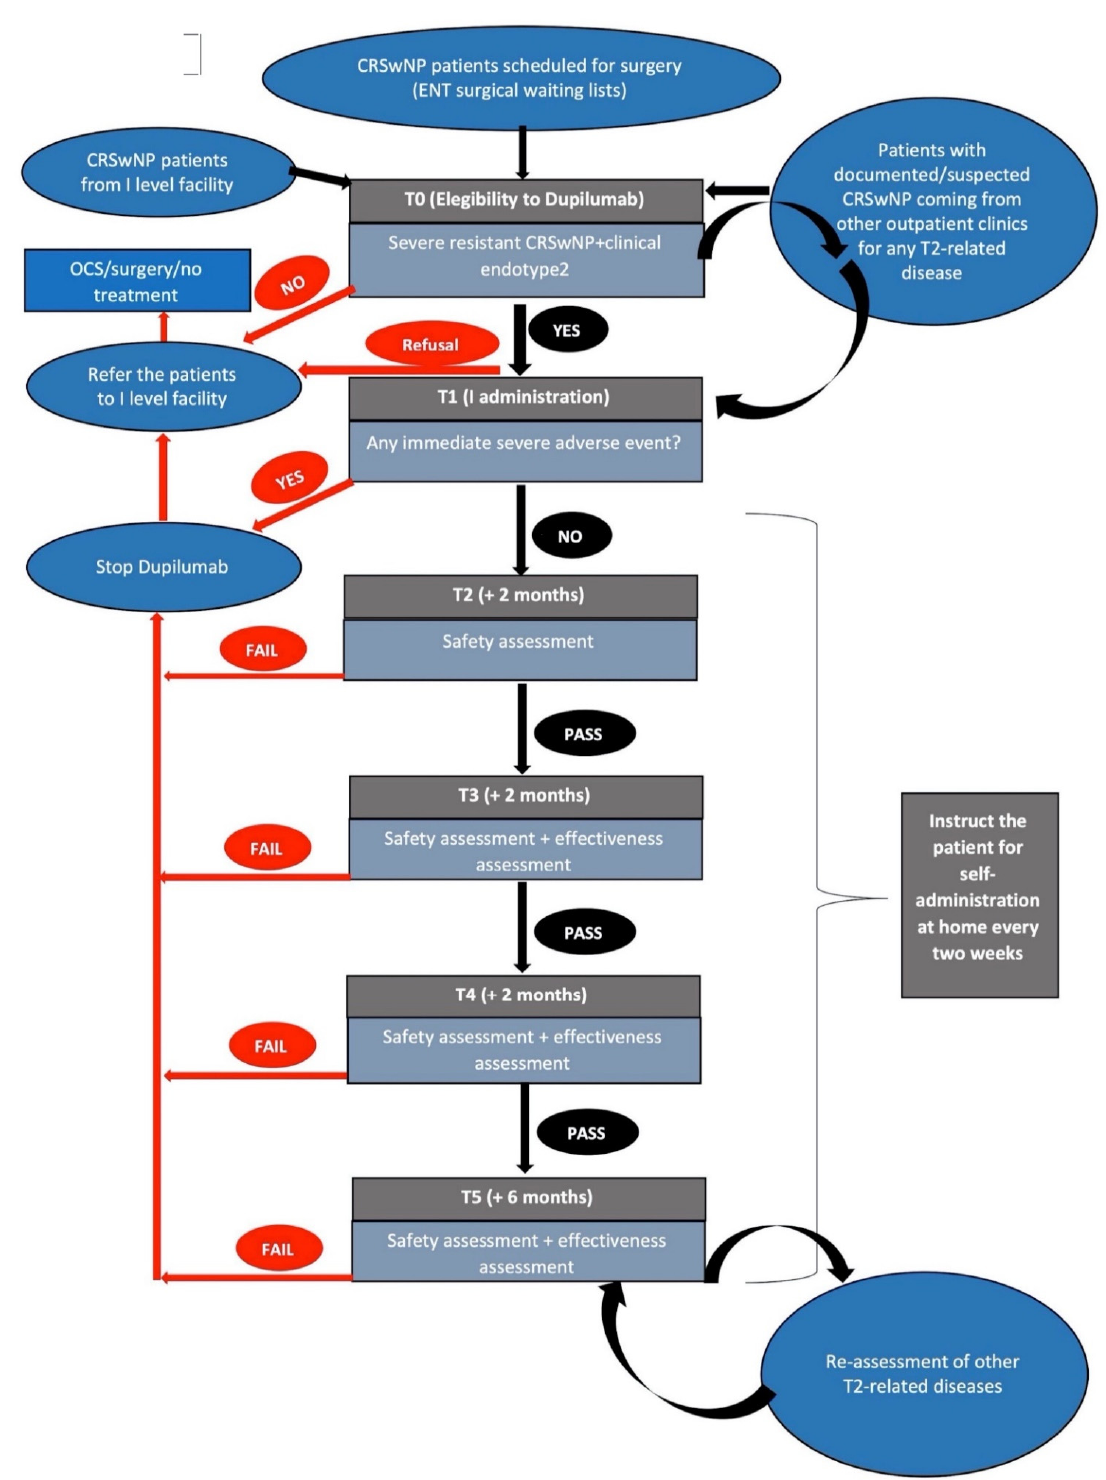
Figure 1. Flow-chart of patients within the outpatient clinic. Abbreviations: CRSwNP: chronic rhinosinusitis with nasal polyps; ENT: ear, nose, and throat; OCS: oral corticosteroids. Legend: T0 (baseline evaluation), T1 (first administration), T2 (follow-up evaluation after 2 months of treatment), T3 (follow-up evaluation after 4 months of treatment), T4 (follow-up evaluation after 6 months of treatment), T5 (follow-up evaluation after 12 months of